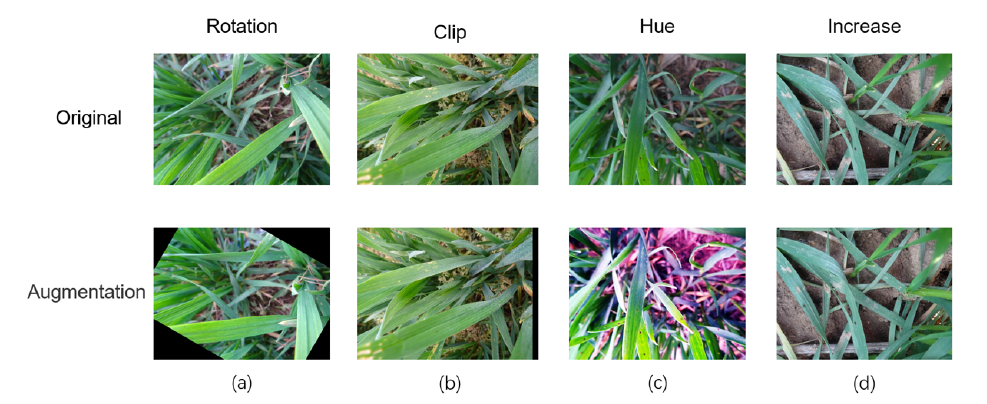
Figure 2. The examples of different data enhancement methods: ( a ) rotation; ( b ) crop; ( c ) color; ( d ) copying wheat spider